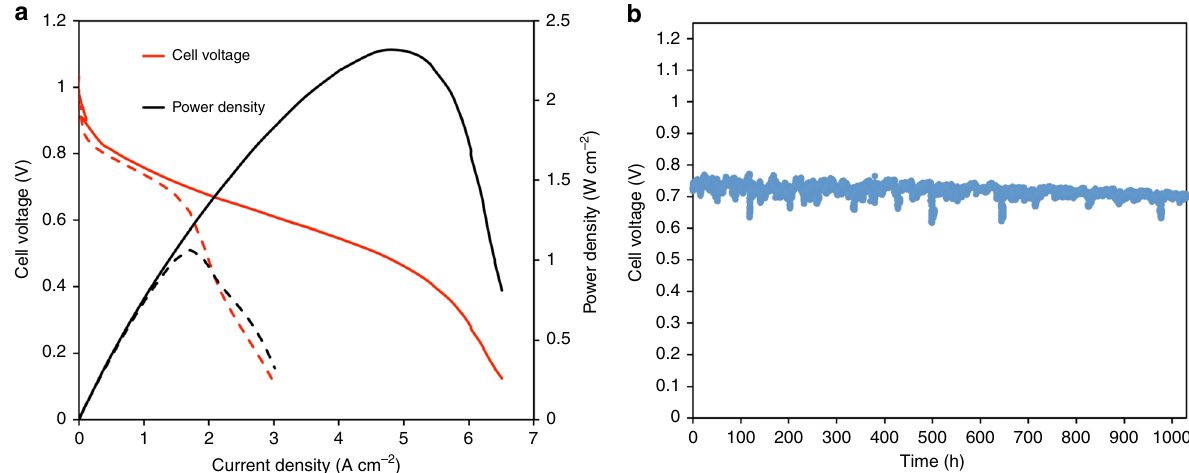
Fig. 8 AMFC performance and stability using PTFE-added electrodes. a i-V and i-power density curves (10 mV s − 1 forward scans, solid line H 2 /O 2 , dashed line H 2 /Air (CO 2 free) at 1 L min − 1 ) of an AMFC with 8% PTFE in the CL and 20% PTFE in the GDL for both the anode and cathode; ( b ) voltage vs. time at a constant current density of 600 mA cm − 2 under H 2 /Air (CO 2 free) fl owed at 1 L min − 1 . The cell was held at 65 °C with both the anode and cathode RH set at 100%. The anode and cathode RHs were slightly adjusted to remove recoverable performance losses during the stability tests. The anode and cathode loading were 0.70 mg PtRu cm − 2 and 0.60 mg Pt cm − 2 , respectively. The membrane used was HDPE 5 . The data is presented without iR-